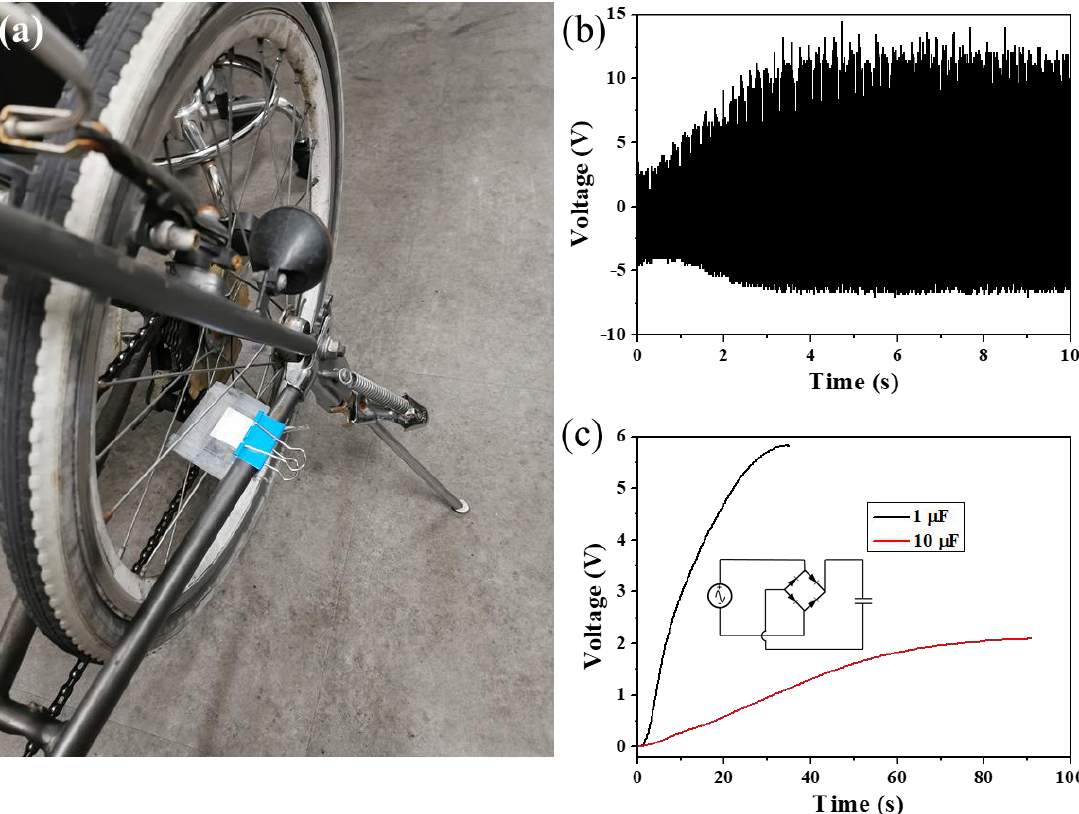
Figure 8. ( a ) PENG placed on a bicycle. ( b ) Output voltage generated from the bicycle. ( c ) Charging voltages of different capacitors; inset: schematic circuit diagram of the commercial capacitor.